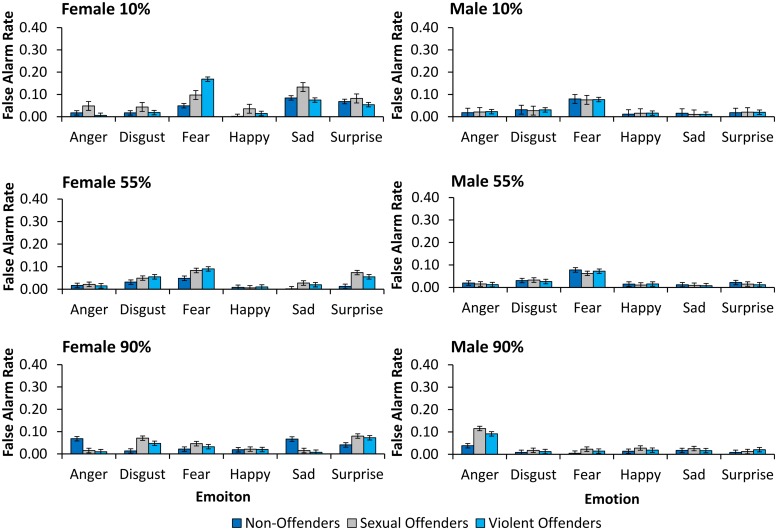
False alarms (FAs). FAs are shown by classification type for female faces at low intensity, male faces at low intensity, female faces at moderate intensity, male faces at moderate intensity, female faces at high intensity, and male faces at high intensity, for non-offenders, sexual offenders, and violent offenders. Error bars = SE mean.